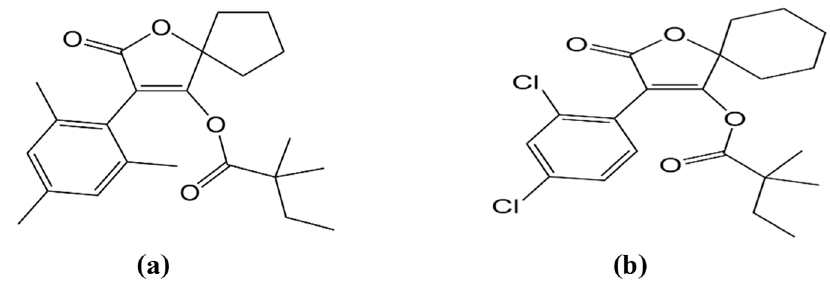
Figure 1. Chemical structure of spiromesifen ( a ) and spirodiclofen ( b ).